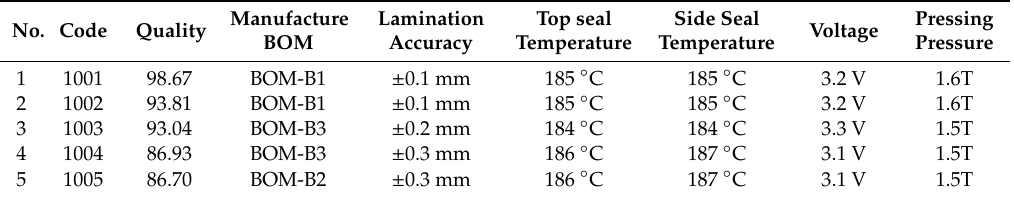
Table 12. Correspondence between battery quality and electrolyte proportion parameters.